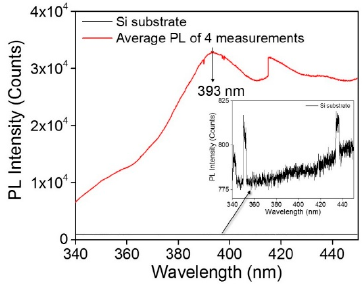
Figure 11. Room temperature average photoluminescence spectrum of ZnO NP embedded PMMA nano layer over Si substrate taken at four different positions. The inset corresponds to the PL measurements of the silicon (Si) substrate as a reference.